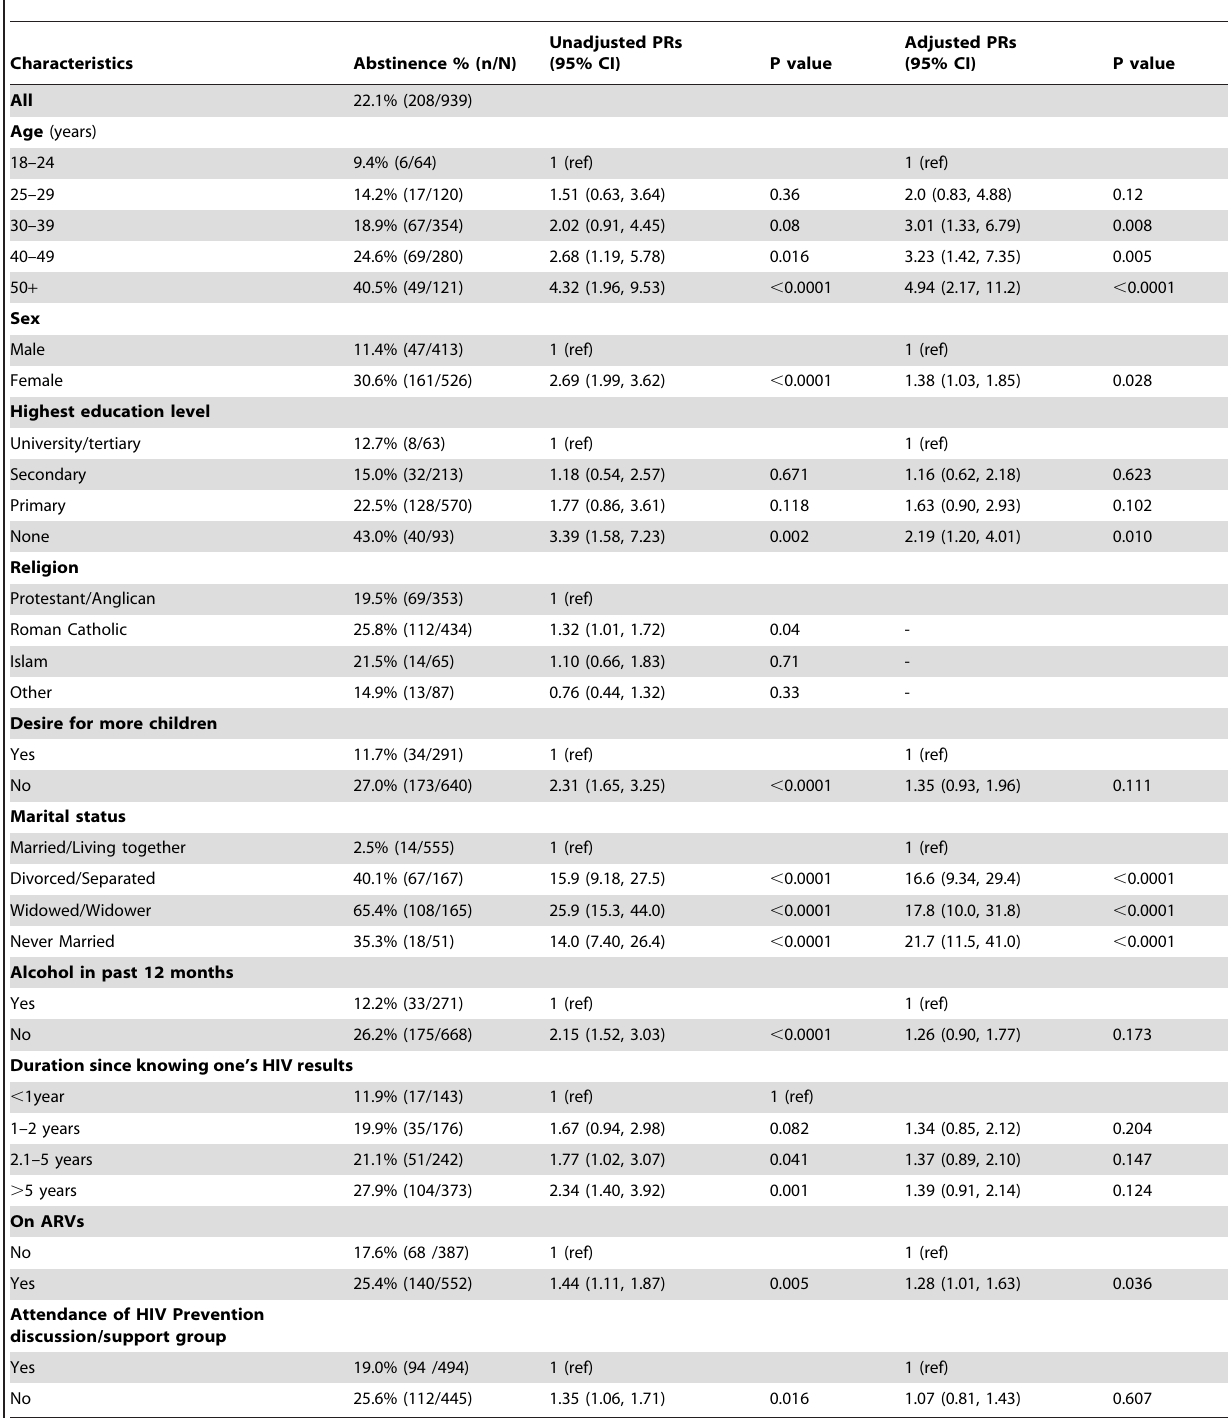
Table 4. Prevalence, unadjusted and adjusted prevalence ratios (PRs) of factors associated with abstinence in past 12 months among HIV positive clients attending CSO health facilities in